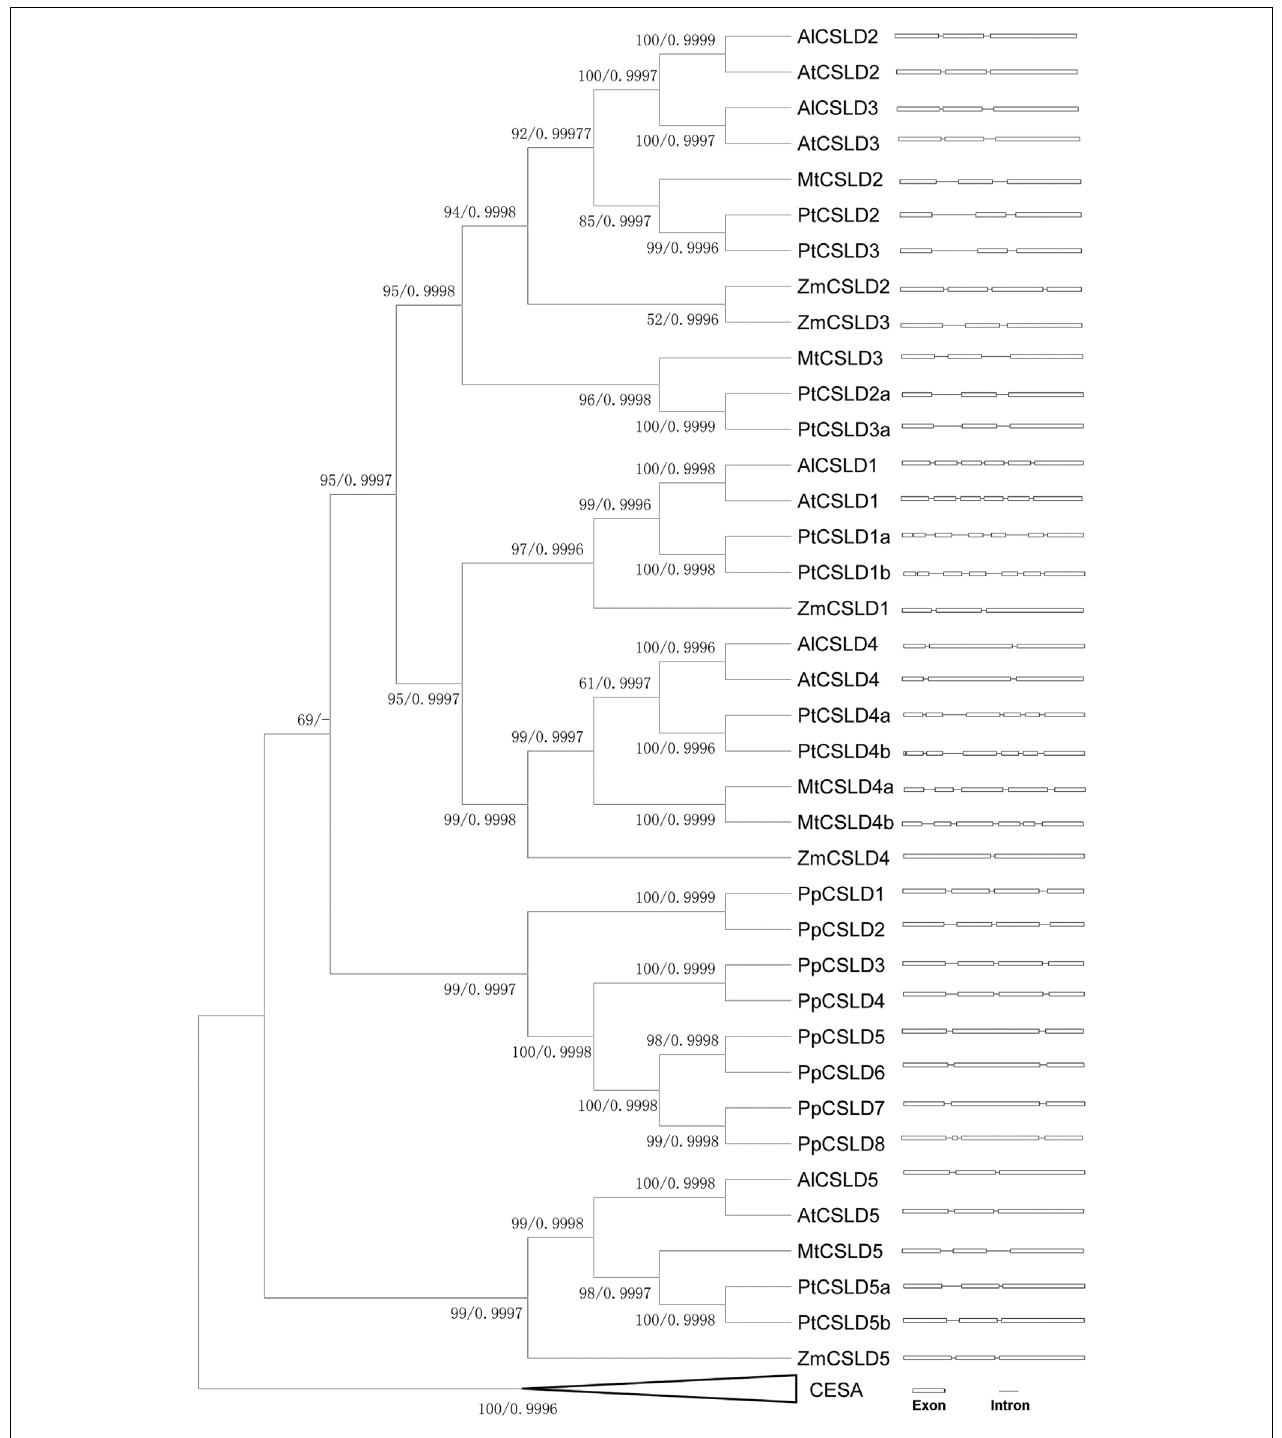
FIGURE 6 | Phylogenetic tree and intron-exon distribution of CSLD s from Arabidopsis thaliana , A. lyrata , Populus , Medicago , maize, and Physcomitrella . Bootstrap support values using MP method and Bayesian posterior values were labeled at each node respectively.